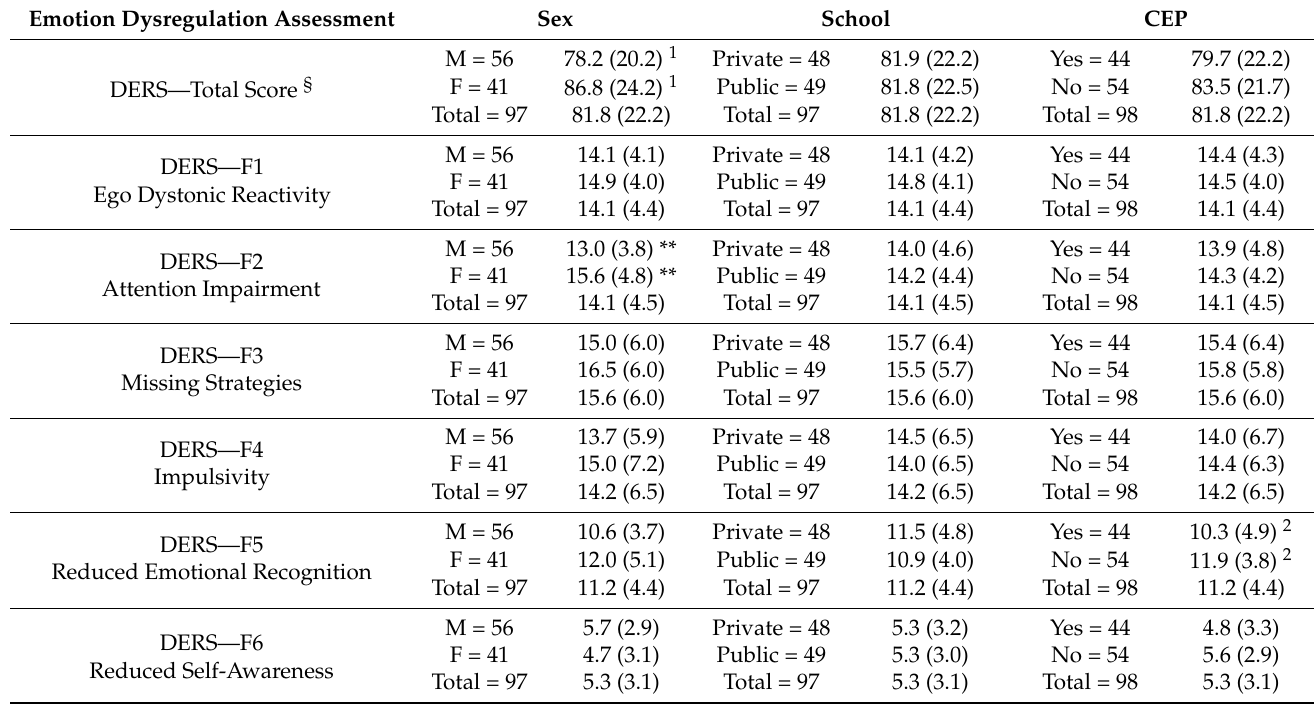
Table 5. Mean and standard deviation of the variables used to assess Emotional Dysregulation (DERS) and their differences by sex, school and participation in CEP.